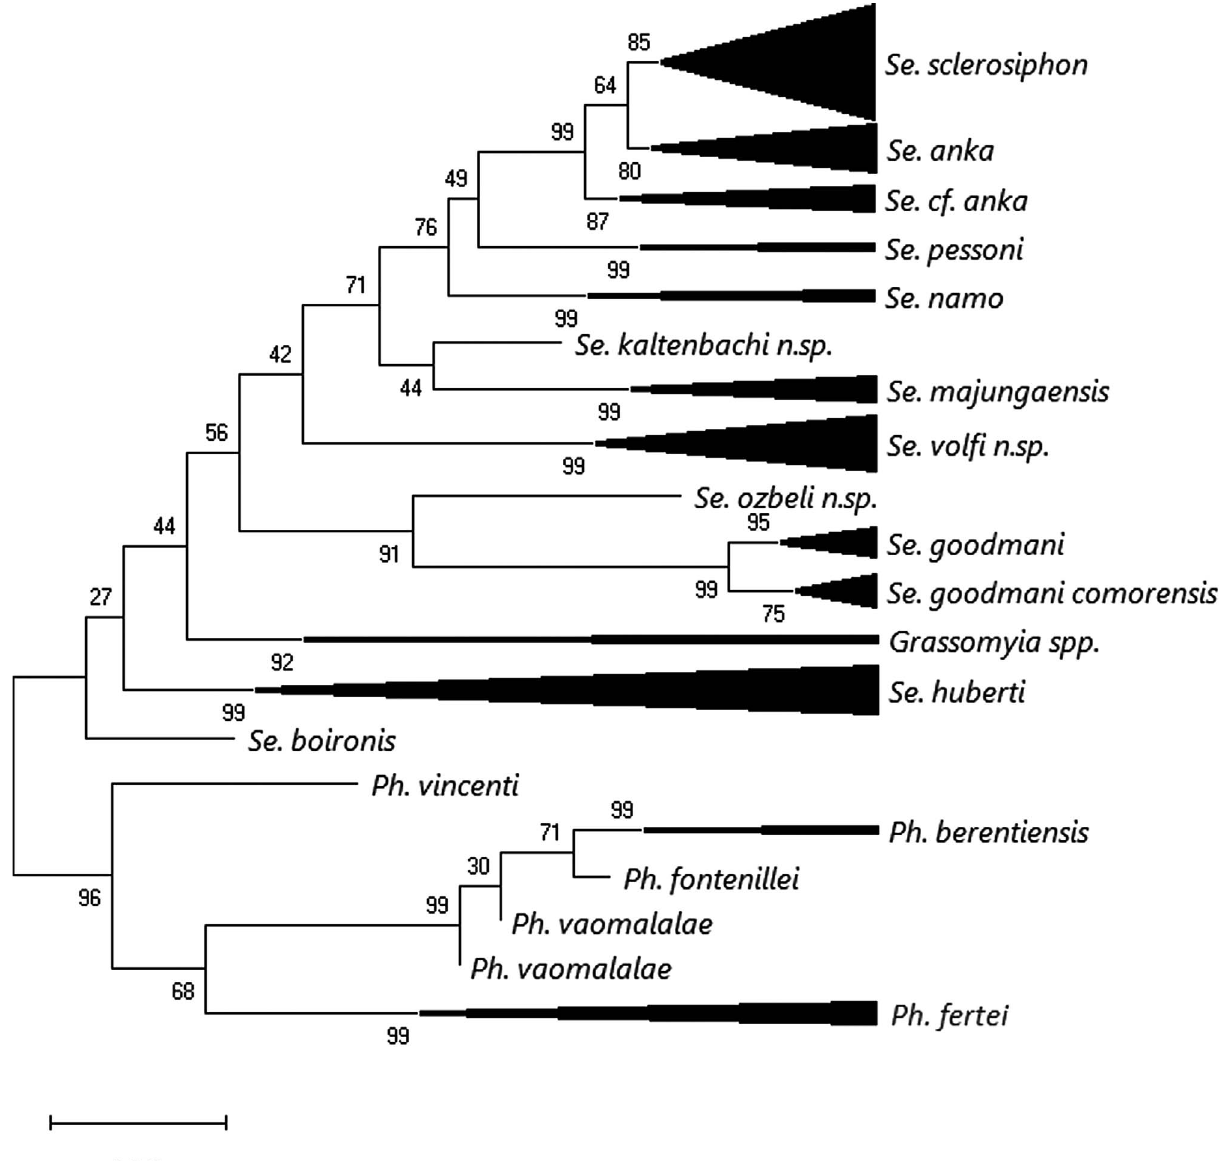
Figure 3. Maximum likelihood tree obtained from partial cyt B sequences based on the HKY85 model after rooting on Phlebotomus spp. The tree with the highest log likelihood ( (cid:1) 2203.9) is shown. The percentage of trees in which the associated taxa clustered together is shown next to the branches. The tree is drawn to scale, with branch lengths measured in the number of substitutions per site. The analysis involved 126 nucleotide